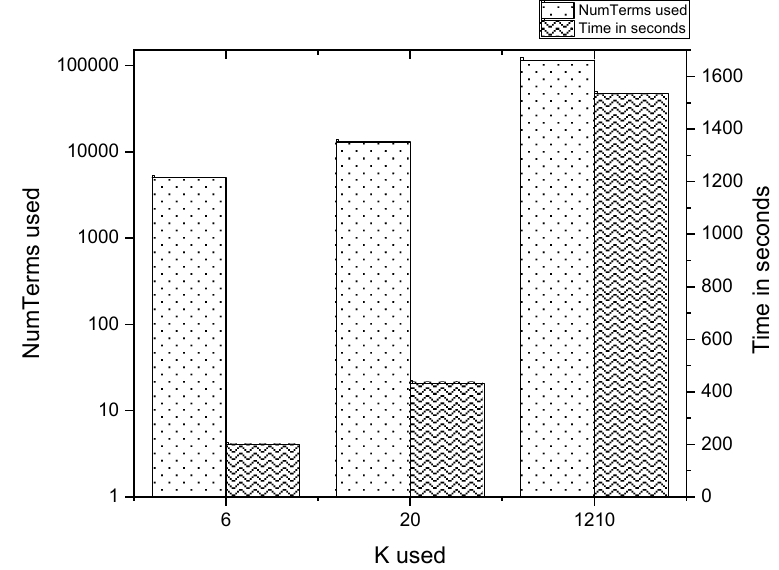
Figure 5. Average execution time based on number of terms and concepts for 1-node cluster.